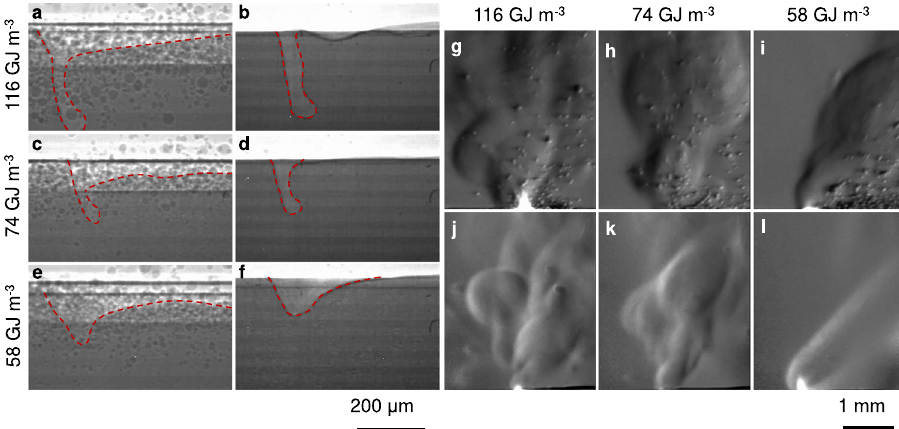
Fig. 10 Comparison of images of line scans with powder and without powder at varying input energy density. a – f X-ray images, showing that regardless of energy, melting powder on top of the substrate does not produce large differences in the surface depression, because the laser beam interacts mainly with molten material. g – l Schlieren images reveal how the plume and atmospheric fl ow interacts with the powder layer. 200 μ m scale bar applies to panels ( a – f ), 1 mm scale bar applies to panels ( g – l ). A video with the images used in this fi gure is available in the supplementary materials.